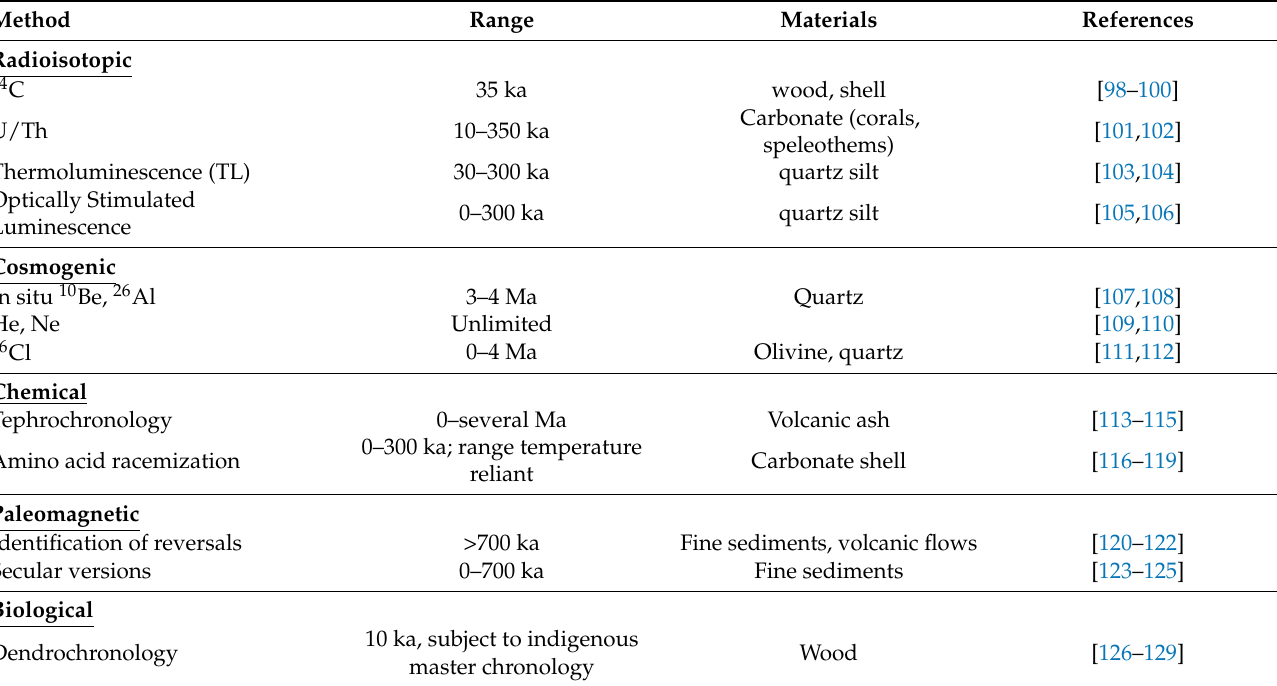
Table 3. An overview of dating techniques that can be used in tandem with environmental DNA.